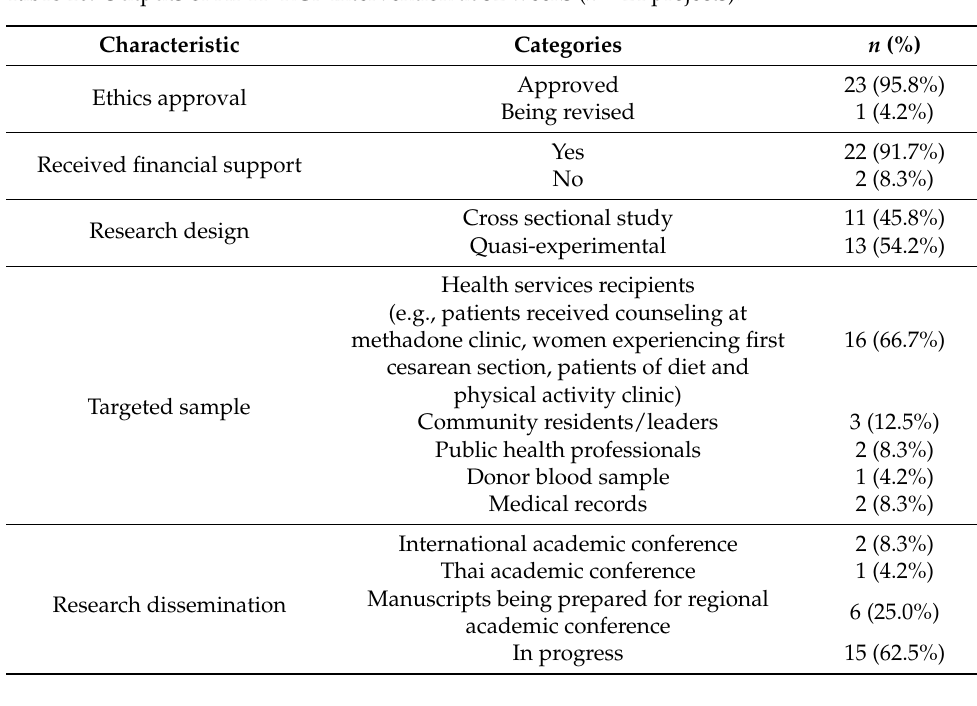
Table 10. Outputs of APTP-RCB intervention at 32 weeks ( n = 24